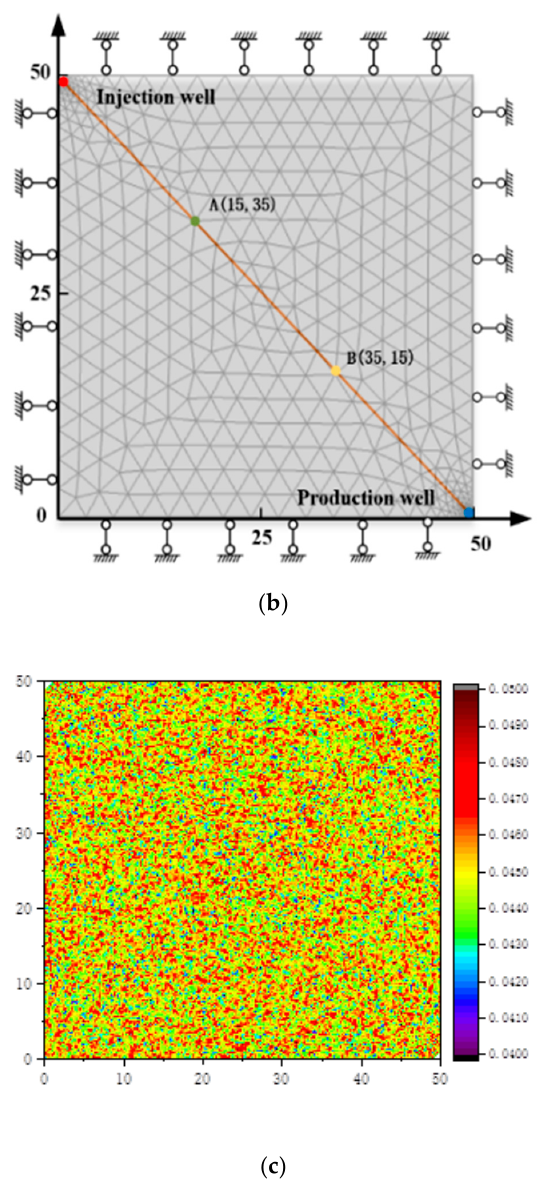
Figure 2. Numerical model of CO 2 displacement of coalbed methane: ( a ) geological model of enhancing CBM recovery by injecting CO 2 with heat injection; ( b ) numerical simulation model for CO 2 -ECBM; and ( c ) initial porosity of CO 2 -ECBM. Table 1. Numerical simulation parameter [25,26,28].